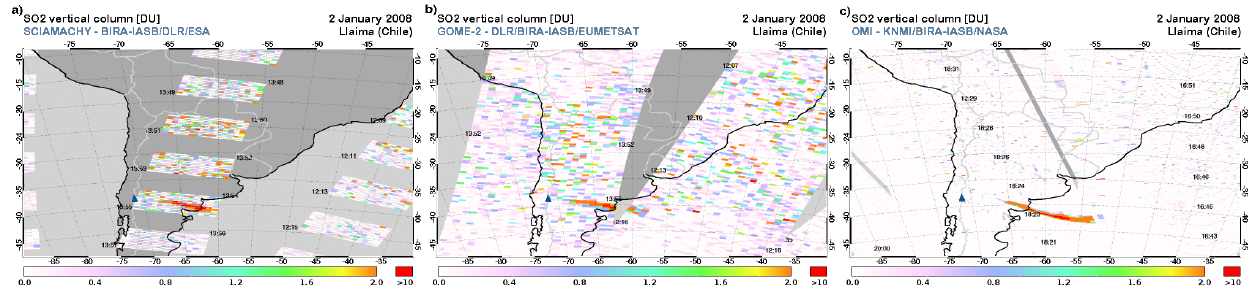
Fig. 5. Example of SO 2 VCD from (a) SCIAMACHY, (b) GOME-2A and (c) OMI on 2 January 2008 in the region affected by the SAA. The SO 2 plume is related to the eruption of the Llaima Volcano (Chile), marked by a blue triangle in the plots. Artefacts induced by the South Atlantic Anomaly in the SO 2 VCD from SCIAMACHY and GOME-2 instruments are visible in these images; OMI is less